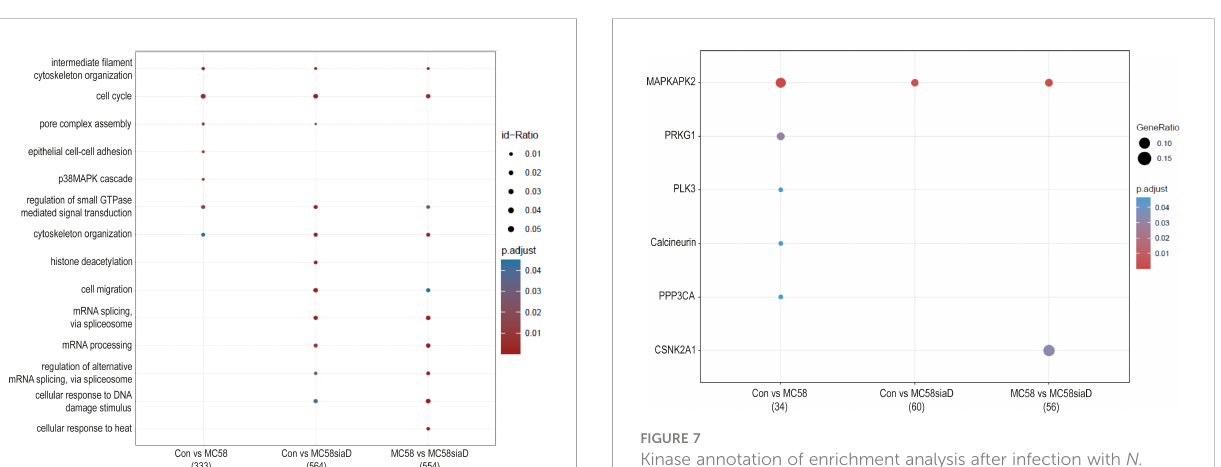
FIGURE 7 Kinase annotation of enrichment analysis after infection with